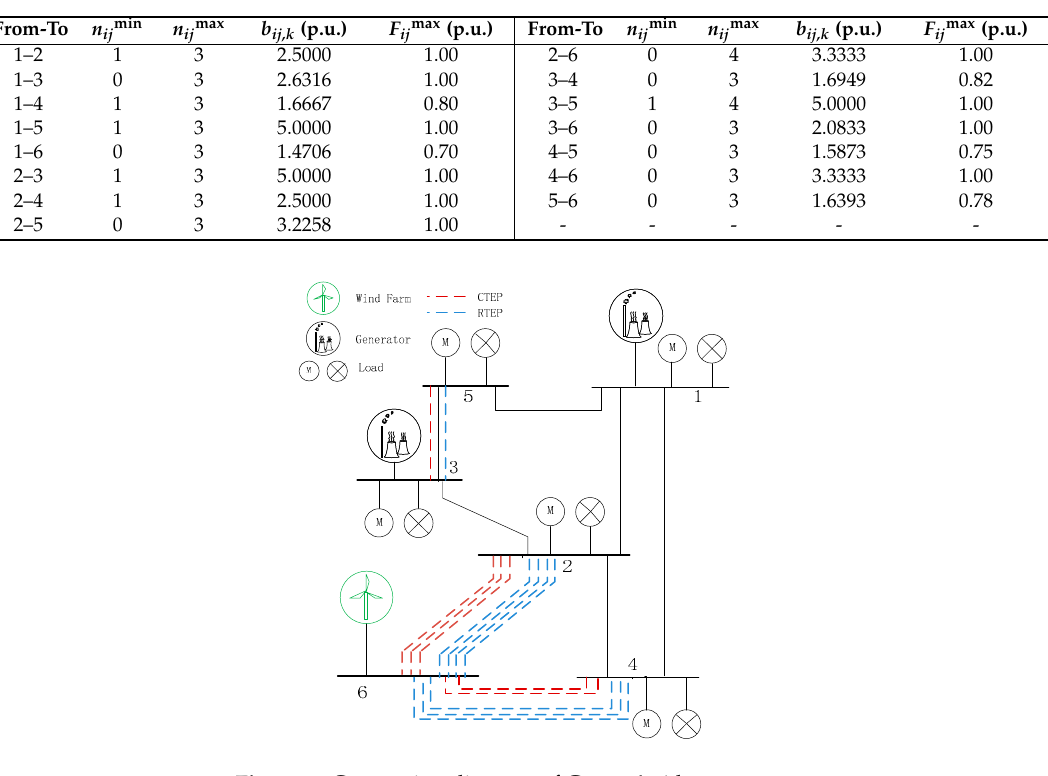
Figure 3. Connection diagram of Garver’s 6-bus system.